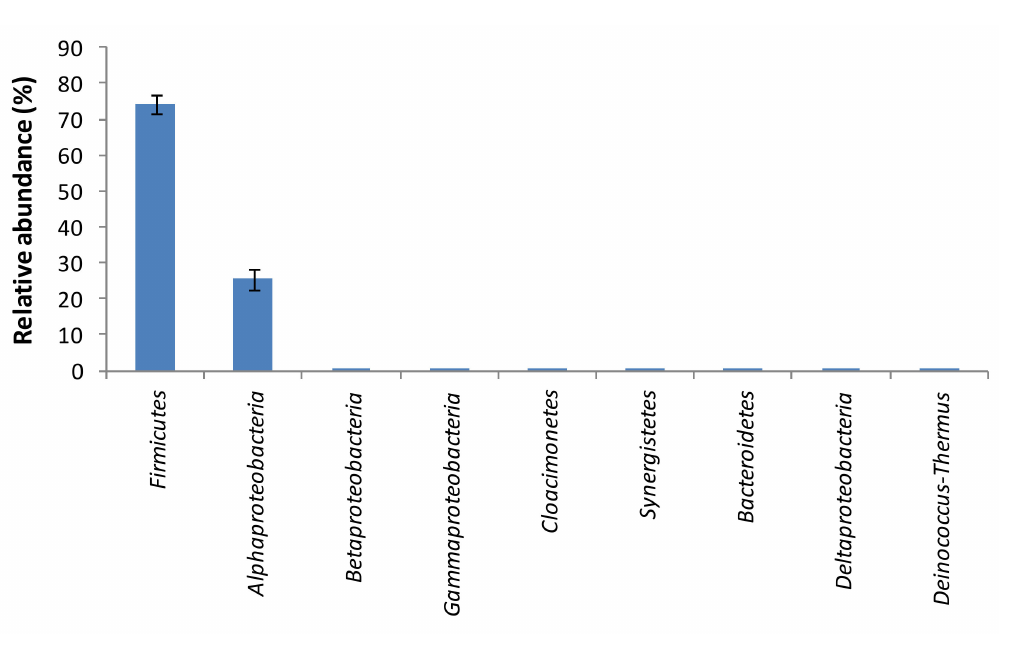
Figure 4. Bacterial diversity at phylum/class level in the orange juice processing waste examined by Illumina assay